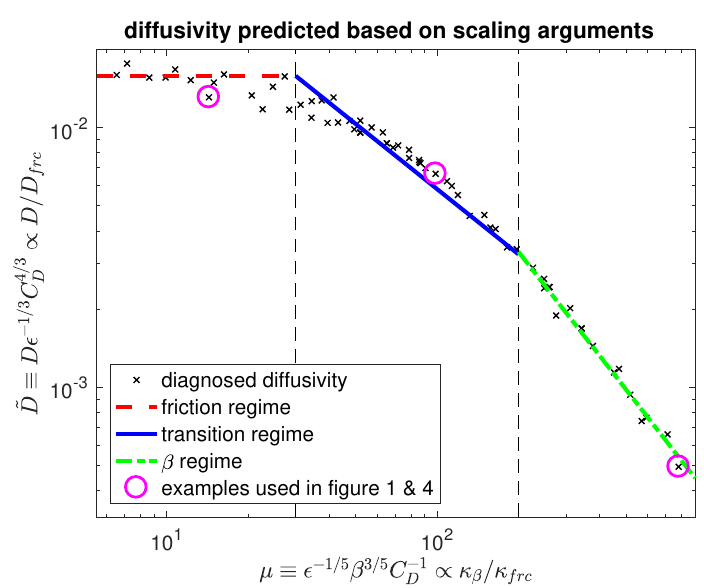
Figure 3. Diagnosed and predicted eddy diffusivity based on scaling arguments. The x -axis is the non-dimensional parameter µ , the y -axis shows the non-dimensionalized eddy diffusivity. Black crosses are the diagnosed diffusivity from numerical simulations; colored lines denote the predicted eddy diffusivity for the three regimes; vertical black dashed lines indicate the boundaries between different